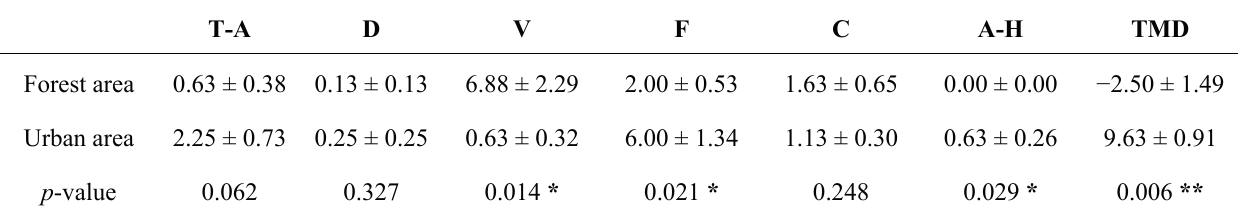
Table 3. Summary of the comparison of POMS between the forest and urban